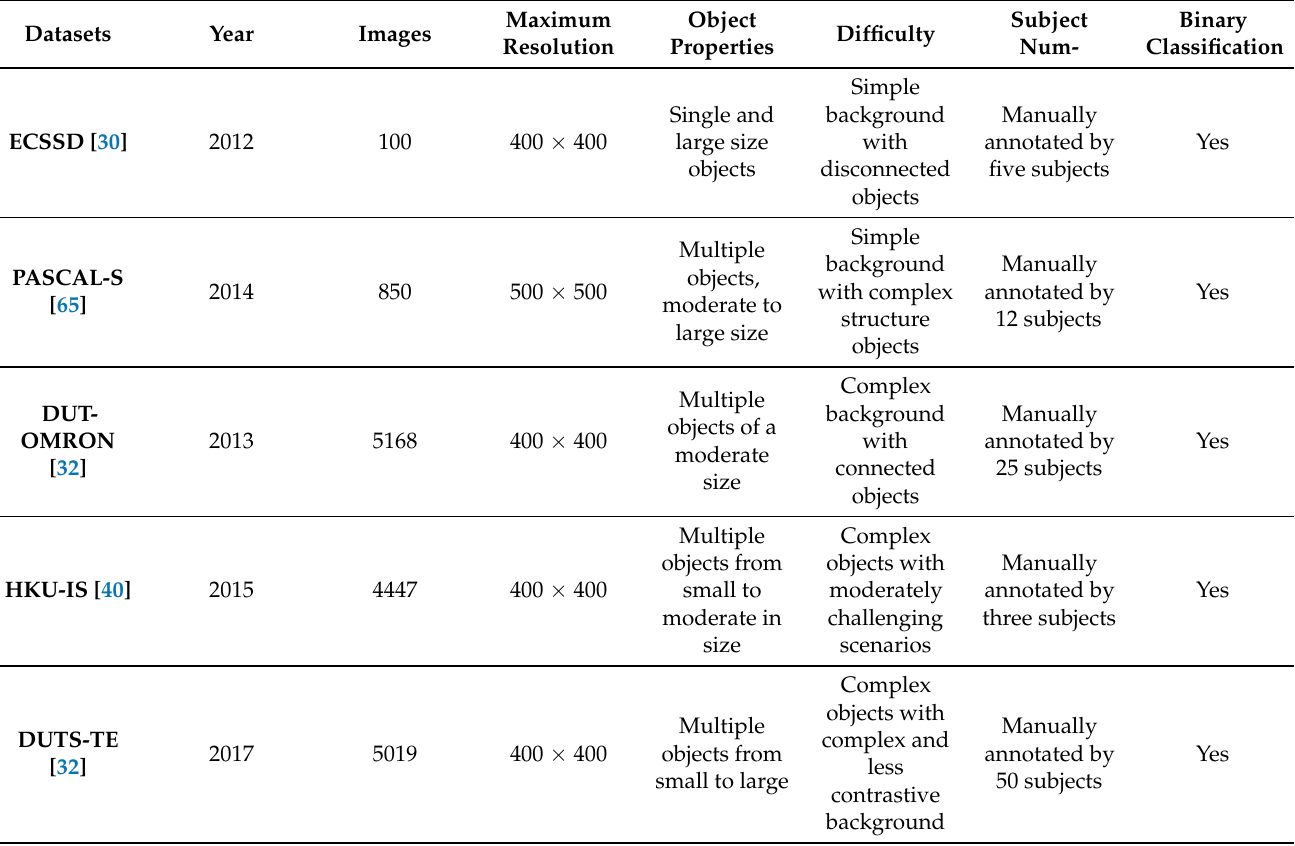
Table 1. Overview of the SOD-based datasets used to evaluate